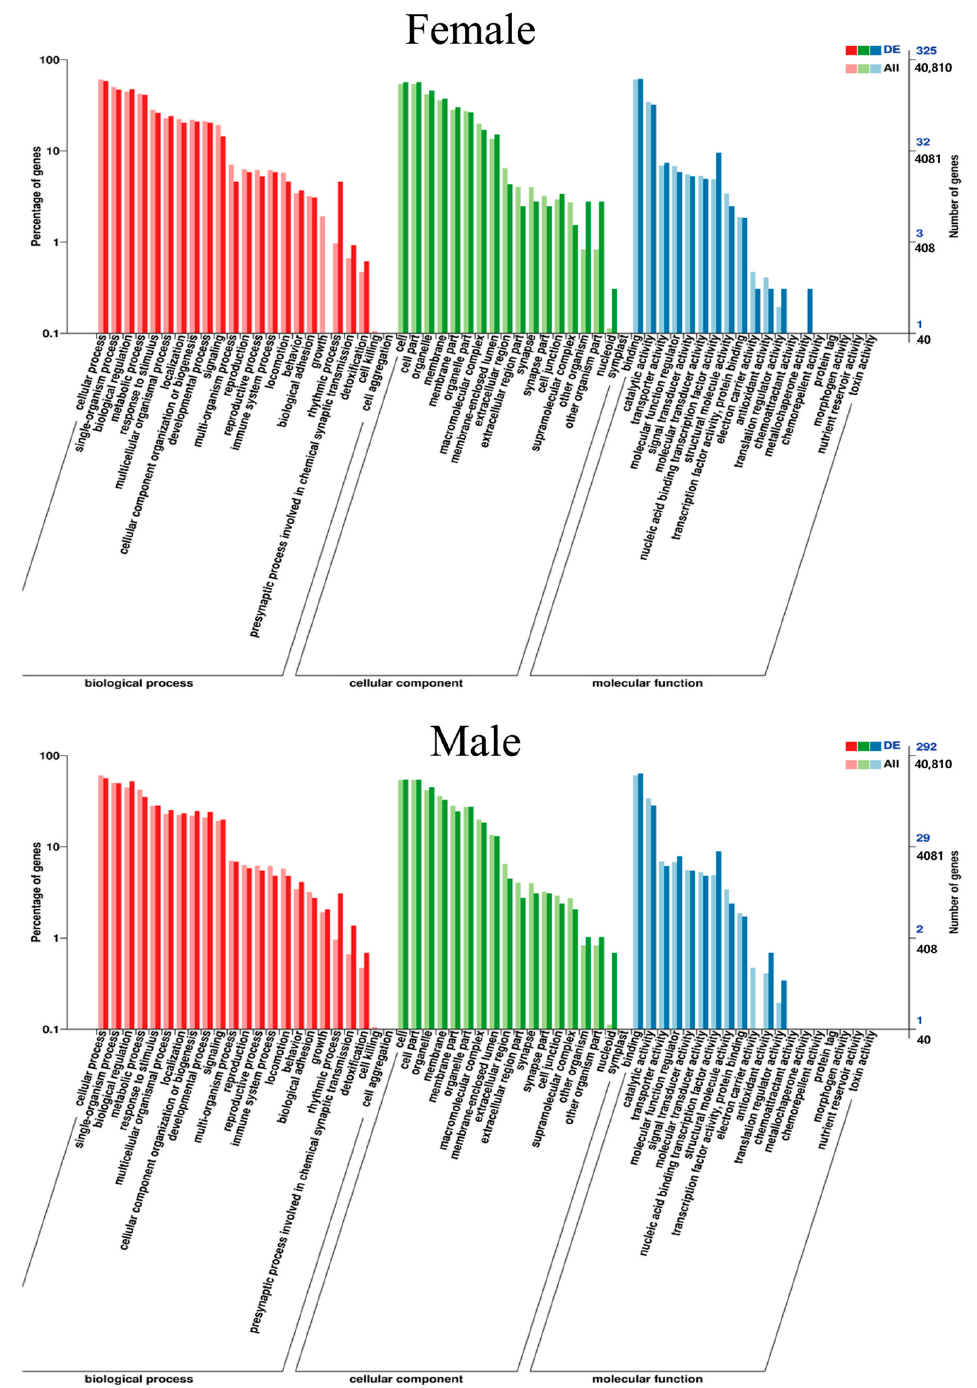
Figure 6. Statistical graph of GO secondary node annotation of differentially expressed genes in G. rarus after exposure to MT for 14 days.